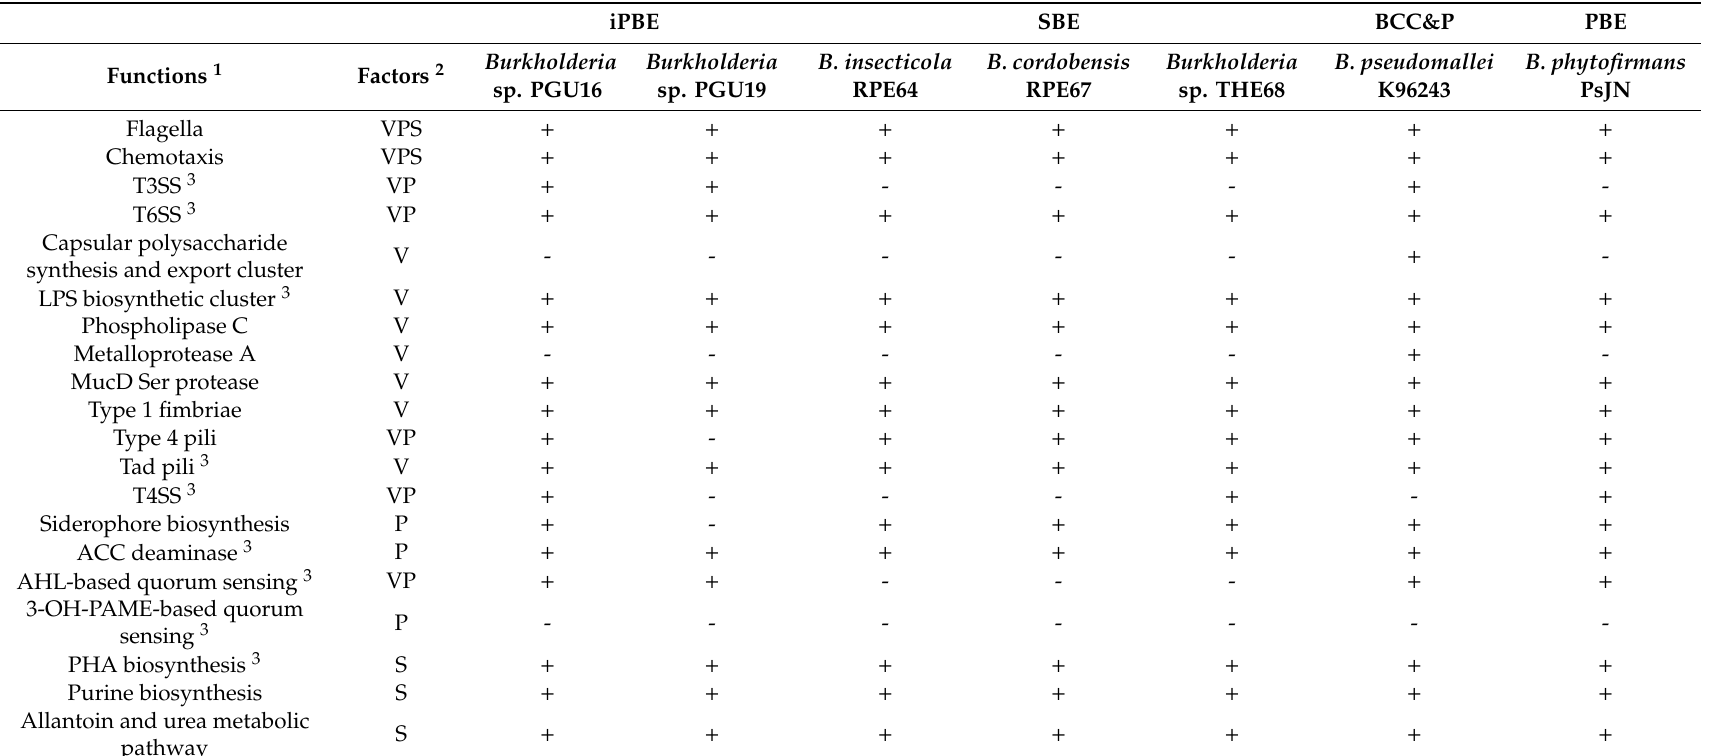
Table 3. Presence / absence of the virulence and symbiosis factors in seven Burkholderia genomes.